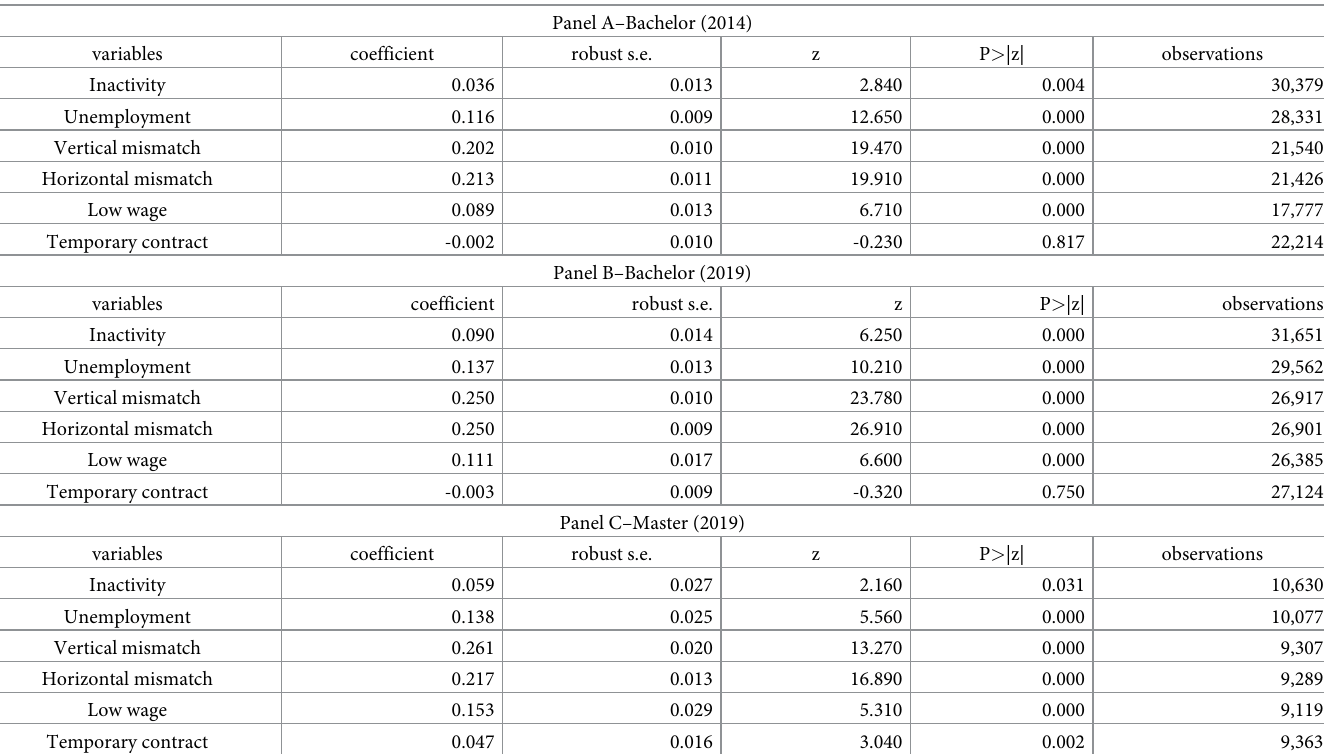
Table 5. Estimates of the effect of job placement results on dissatisfaction with university